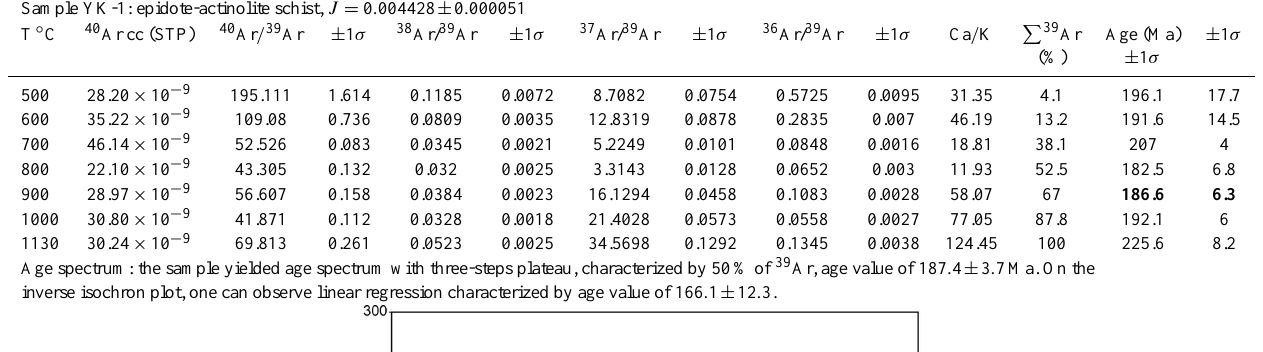
Table 2c. Whole-rock 40 Ar / 39 Ar age data for an epidote-actinolite schist rock from a metamorphic block in the Ankara Mélange, Turkey.